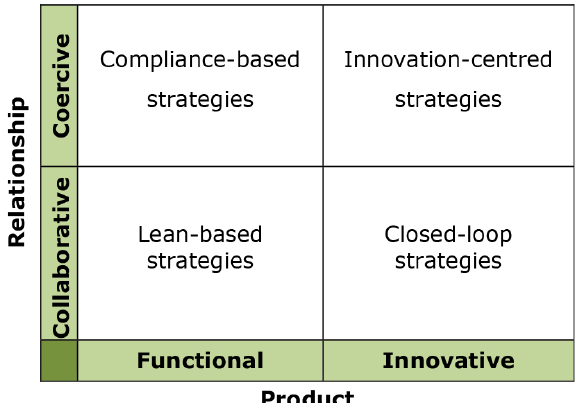
Figure 3. Relationship-Product characteristics and green strategies